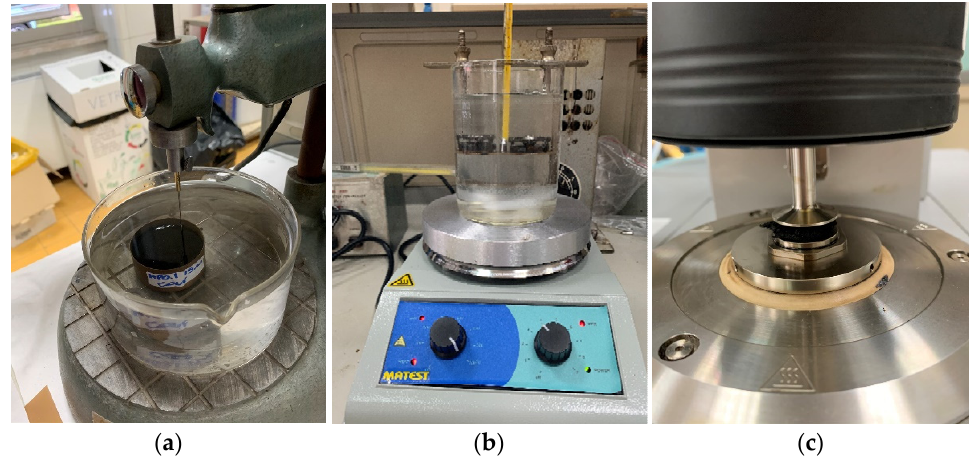
Figure 5. Investigation of the performance of asphalt mastics: ( a ) penetration device, ( b ) R&B equipment, and ( c ) DSR configuration for frequency sweep and MSCR tests.